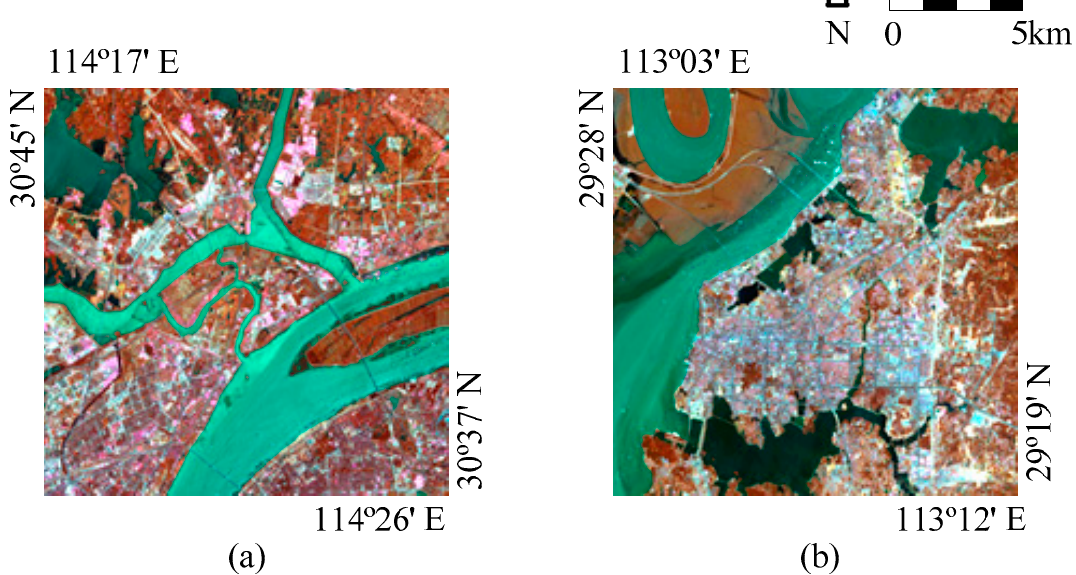
Figure 4. Representative study areas. ( a ) Wuhan city; ( b ) Yueyang city.